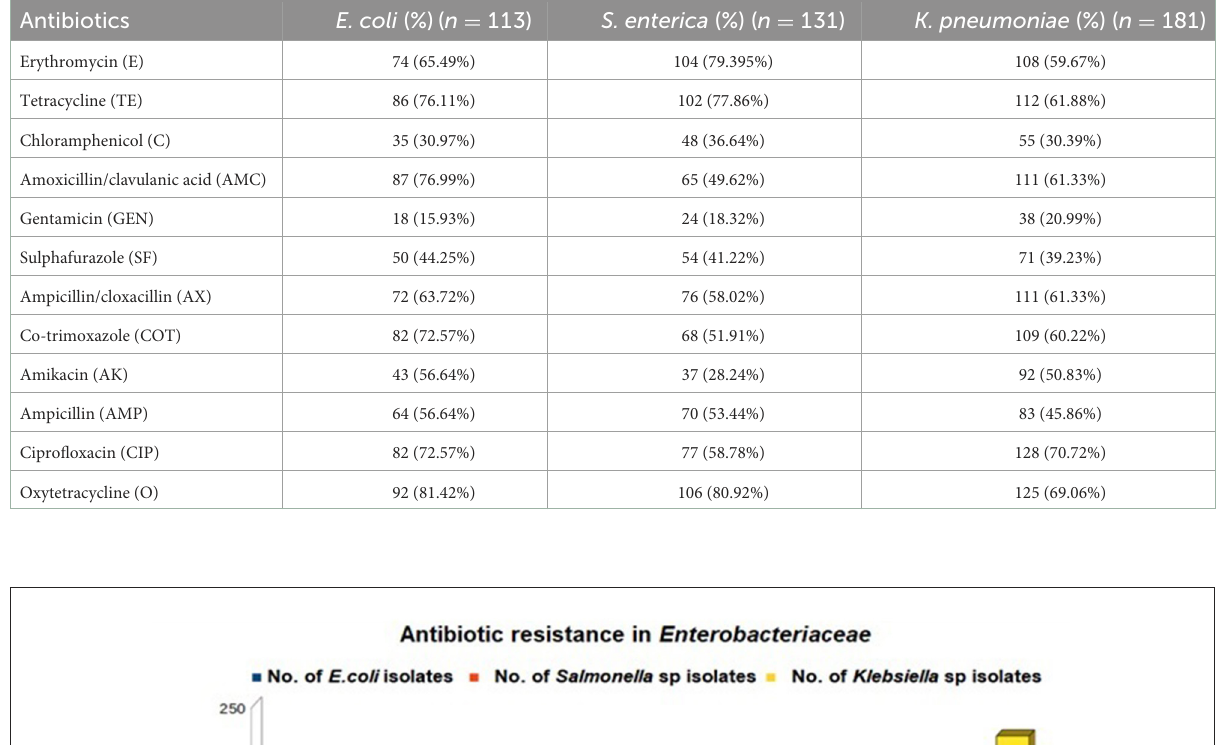
TABLE 2 Phenotypical antibiotic resistance in Enterobacteriaceae strains isolated from poultry in Andaman and Nicobar Islands (India).